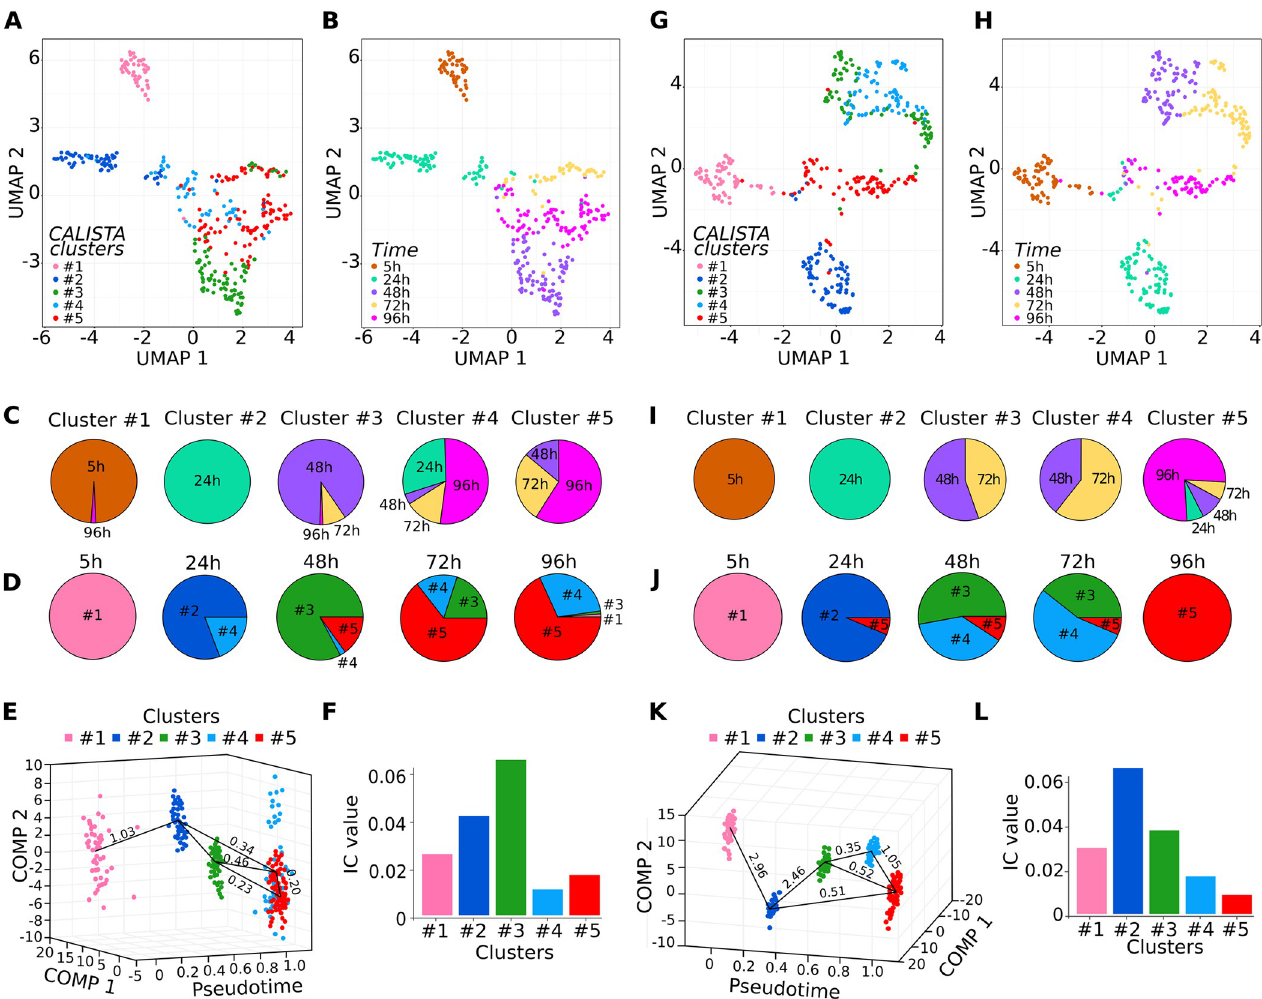
Fig 2. Evolution of transcriptome profiles after cell stimulation. The 2 donors are presented separately: donor1 on the left panels ( A to F ) and donor2 on the right ( G to L ). ( A , B and G , H ) UMAP visualization of the single-cell RNA data. Each point represents a single cell. The cells belonging to the same cluster identified by CALISTA are color coded on ( A and G ). On ( B and H ), the cells are colored according to the time point they were collected. Note the good agreement with the separate UMAP groups. ( C and I ) Composition of the CALISTA clusters according to the time point the cells were collected. CALISTA clustered the cells according to their transcription profile similarity. Note that the heterogeneity of the cell population increases in time and concomitantly to the transcription changes as the individual cells progressed at different pace. ( D and J ) Clusters composition of the groups of cells collected at the different time points. Note the relative homogeneity of the groups at early time points and their gradual diversification at later time points. ( E and K ) Time progression of the cells through different transcription states as determined by CALISTA. The transition edges with the cluster distances are shown. They suggest that different simultaneous trajectories are possible. The cluster color code is the same as in ( D and J ). Comp1 and Comp2 are the first 2 axes of the PCA used by CALISTA for dimensionality reduction. ( F and L ) The index for critical transitions (I c ) calculated separately for each cluster. Note that in both donors, the index reaches the maximum value in clusters #2 and #3, indicating a phase of critical transition. (Numerical values available in scRNA-seq repository GSE156734 : “GSE156734_CALISTA_results_d1csv.gz” “GSE156734_Spread_MARSseq_data_all_filters_20200728.csv” “GSE156734_CALISTA_results_d2.csv.gz”) CALISTA, Clustering And Lineage Inference in Single-cell Transcriptional Analysis; PCA, principal component analysis; UMAP, Uniform Manifold Approximation and Projection.